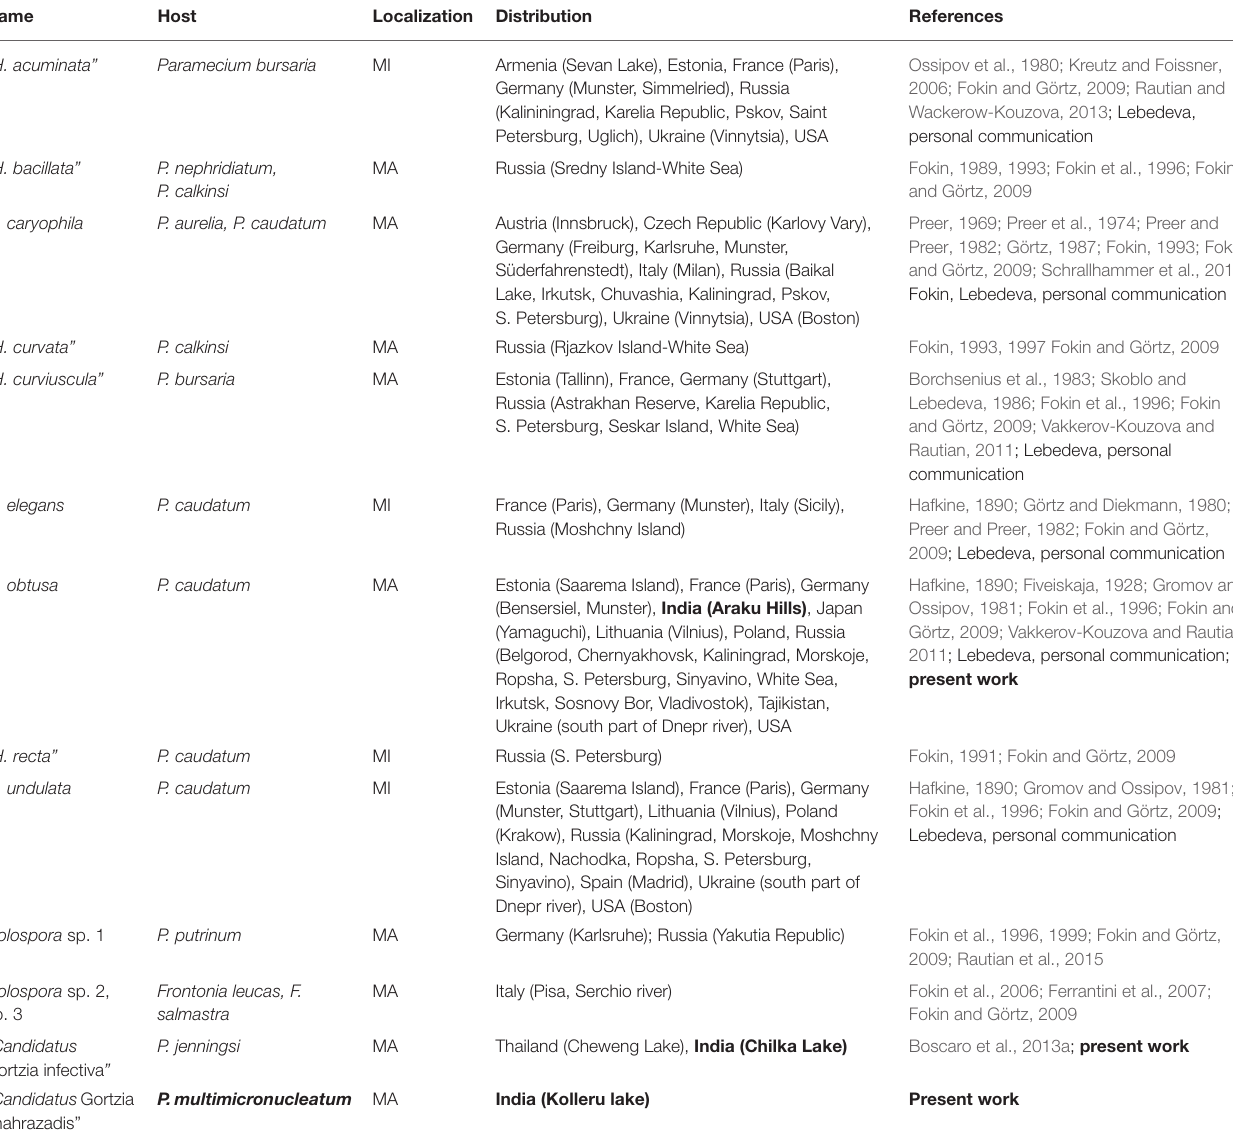
TABLE 3 | Biodiversity and distribution of Holospora -like bacteria from ciliate